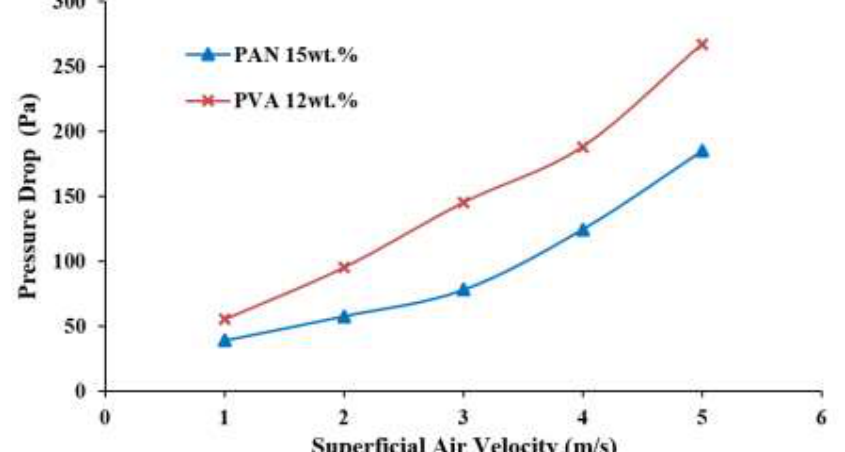
Figure 13: The relationship between space velocity and pressure drop across the PAN and PVA air